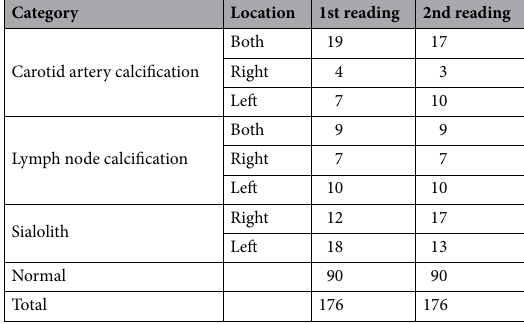
Table 1. Characteristics description of the datasets.